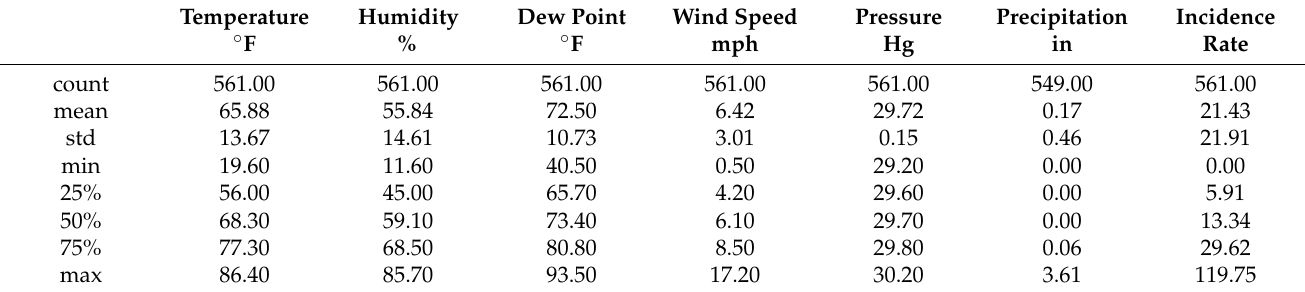
Table 2. Exploratory data analysis of the data sets, including weather data and the COVID-19